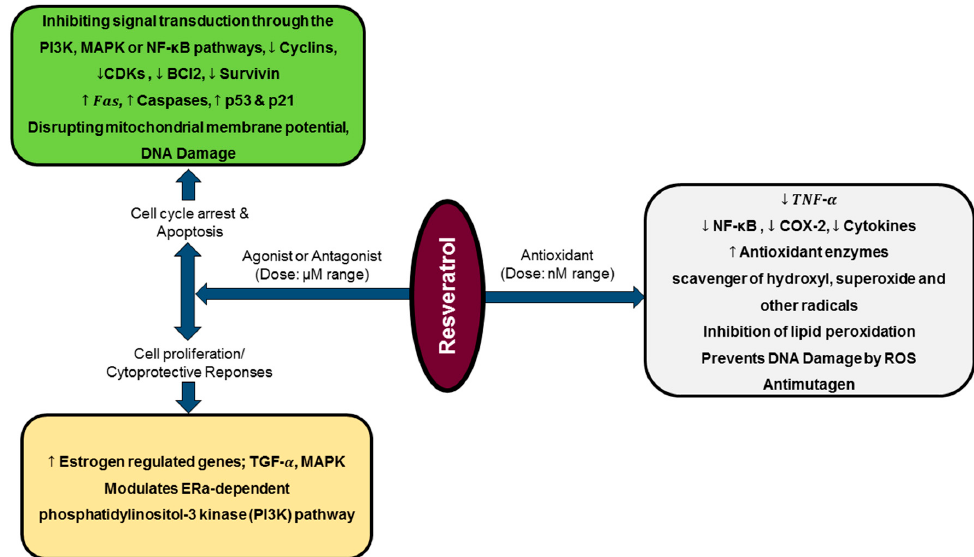
Figure 2. Diagrammatic representation of resveratrol biphasic activity and gene expression modulation. At nanomolar [124] doses, resveratrol acts as a potent antioxidant, while at micromolar ( μ M) range, it interacts as agonist or antagonist exhibiting cell proliferation/cytoprotective responses or cytostatic/apoptotic effects,